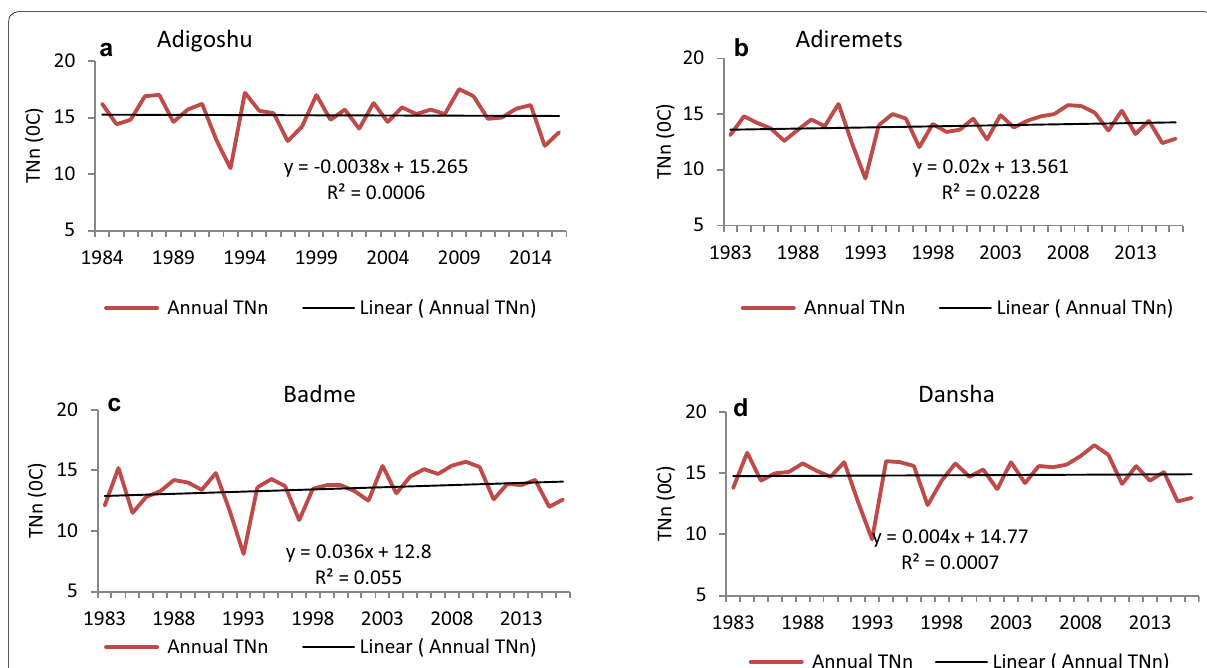
y = -0.0038x + 15.265 R² = 0.0006